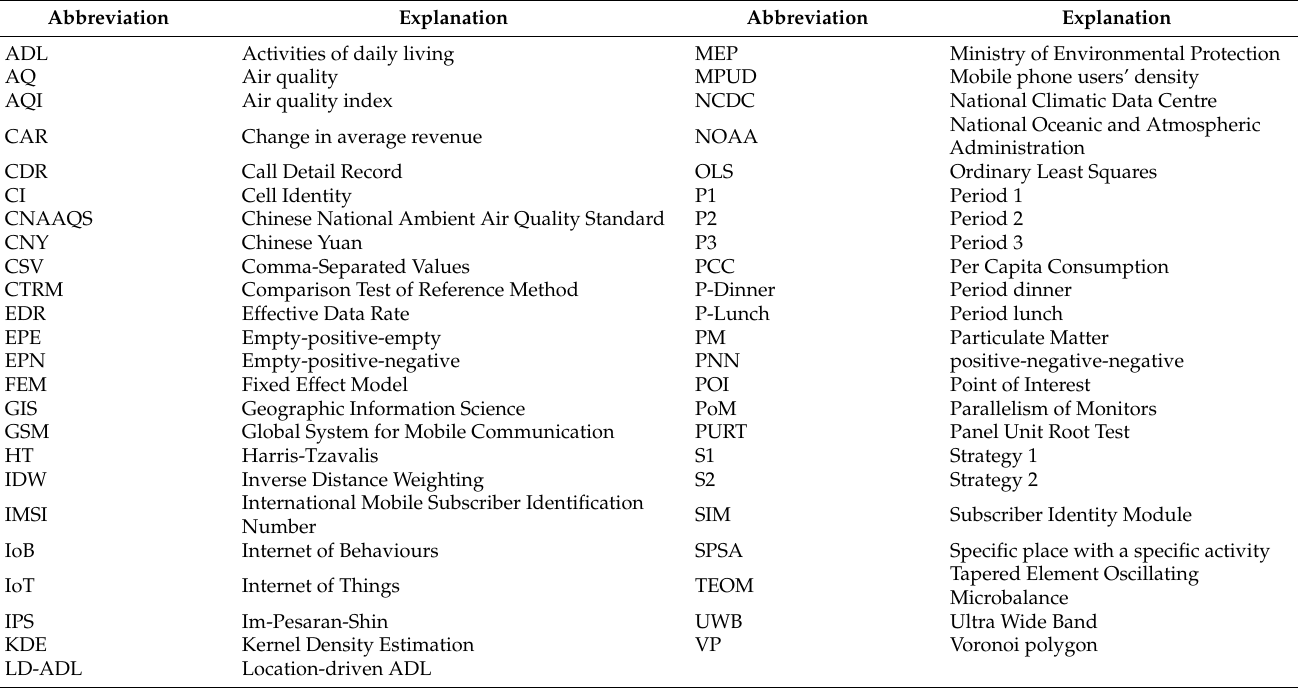
Table 2. Abbreviations and